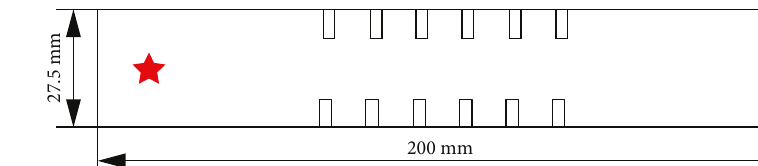
Figure 12: Algorithm validation model.